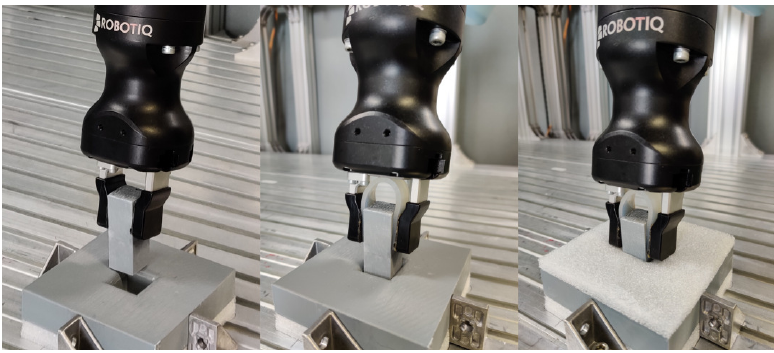
Figure 8. High, medium, and low-stiffness environments (left to right). Table 4. Success rate of a 3D-printed-cuboid insertion task with different degrees of contact